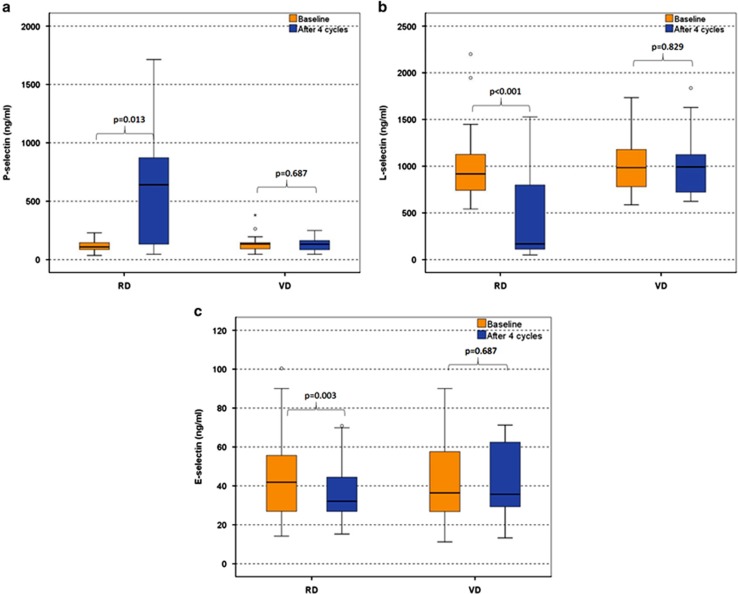
Alterations of P-selectin (a), L-selectin (b) and E-selectin (c) post four cycles of RD and VD; whisker plots (open circles) refer to outlier values, while 'extreme' values are marked with an asterisk.